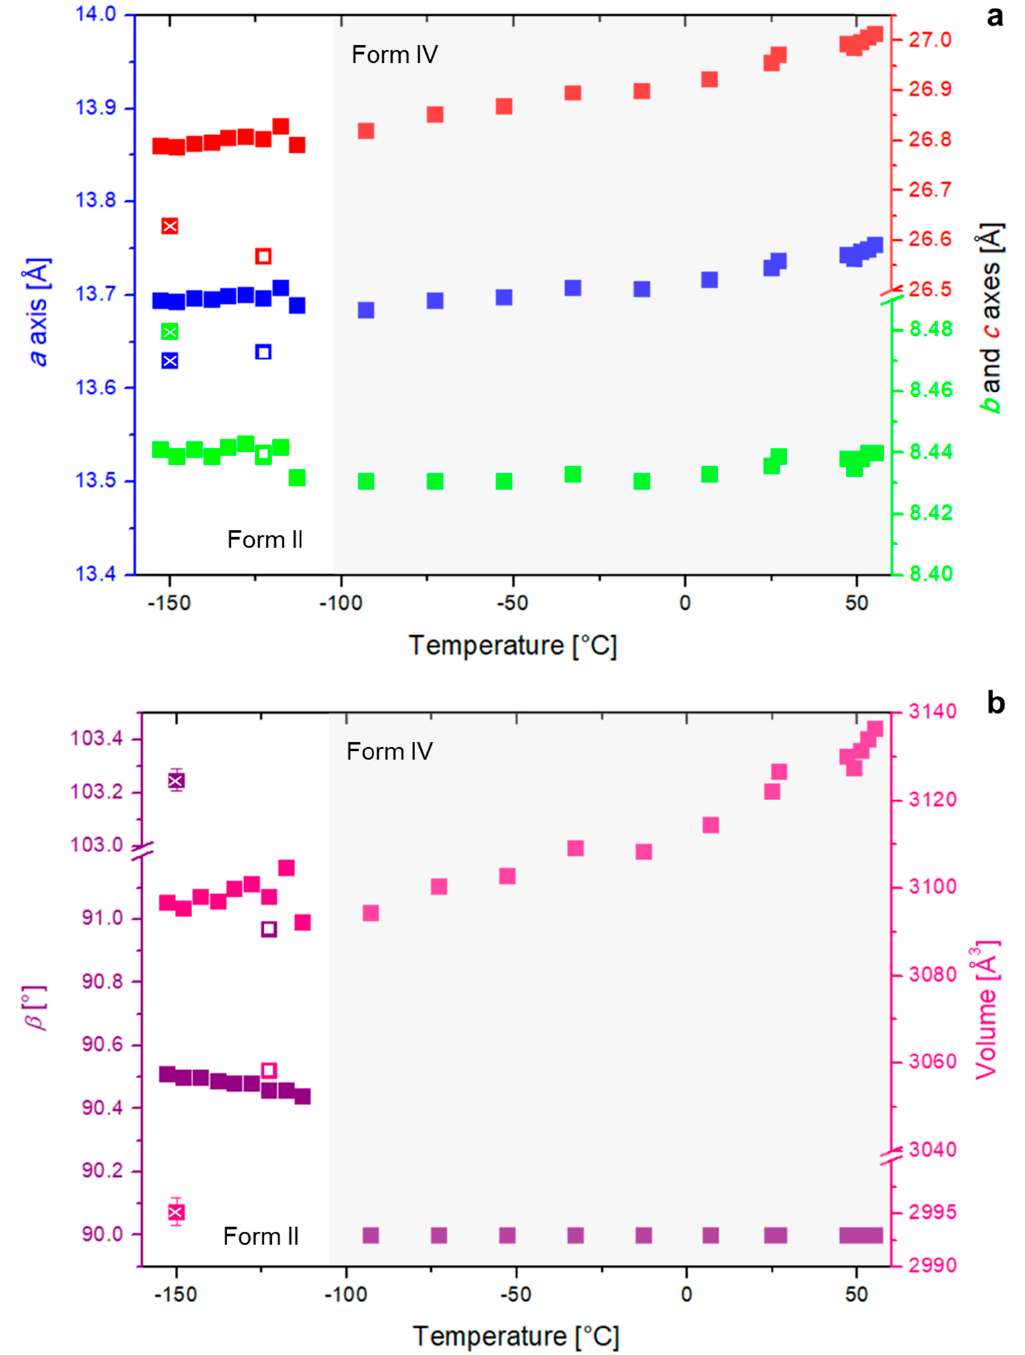
Figure 8. Variation of form II of BDB in different temperature points of the lattice parameters ( a ) and of β angle and volume ( b ). Forms II and III are represented by the white squares and crosses, respectively. Form I was omitted from the graphs. Some standard deviations are too small to be observed in the graphs.